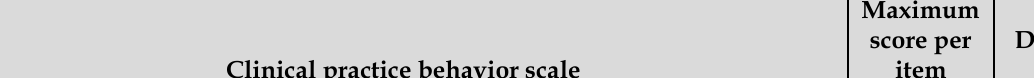
Clinical practice behavior